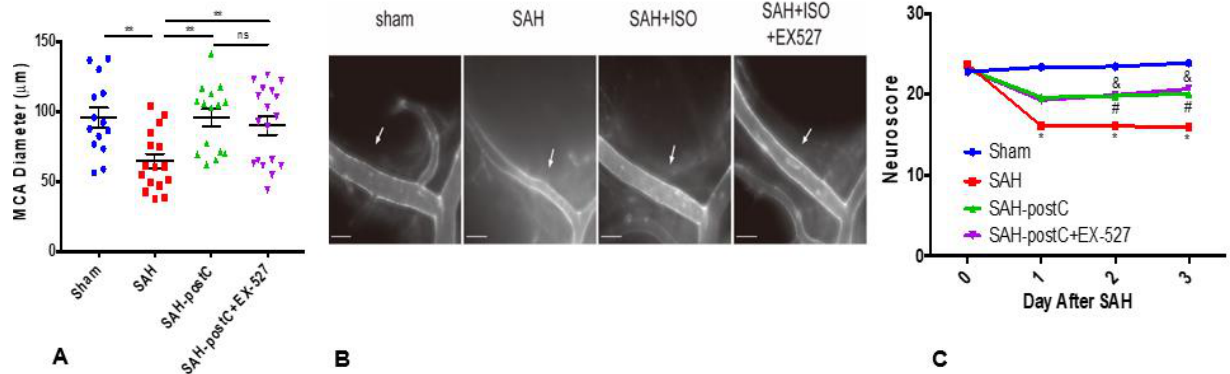
Figure 2. Isoflurane conditioning attenuates SAH-induced vasospasm and improves neurological outcomes with and without EX-527: Wild-type mice were subjected to sham surgery or endovascular perforation SAH and treated with vehicle (DMSO+1.2% cyclodextrin+PBS1X) or EX-527 (10mg/kg) diluted with vehicle. Two out of four groups were exposed to 2% isoflurane for one hour (postC), one hour after SAH, and one isoflurane group out of two received a single dose of EX-527 immediately after SAH. Vasospasm ( A ) was assessed on Day 3. Neuroscore was assessed baseline and daily for 3 days ( C ). Data indicate mean ± SEM. ( A ) ** p < 0.01 sham vs. SAH, ** p < 0.01 SAH vs. SAH+Isoflurane, SAH+Isoflurane+EX-527, p > 0.05 SAH+Isoflurane vs. SAH+Isoflurane+EX-527, by ANOVA and Newman–Keuls multiple comparison test. ns—nonsignificant. ( B ) Representative images for vasospasm. ISO—Isoflurane. Arrow mark represents the middle cerebral artery vessel. Scale bar = 500 µ m. ( C ) p < 0.05 Sham vs. SAH, # p < 0.05 SAH vs. SAH-postC, & p < 0.05 SAH vs. SAH-postC+EX-527 by ANOVA and two-way repeated measures ANOVA with Newman–Keuls multiple comparisons test.